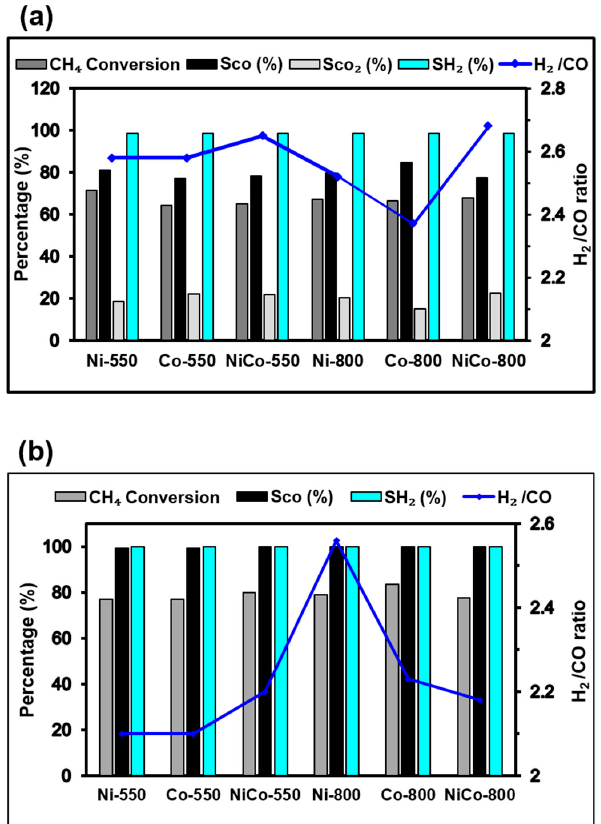
Figure 7. Conversion, selectivity and H 2 /CO ratio obtained for Ni and/or Co-based catalysts operated at ( a ) 700 °C and ( b ) 800 °C.